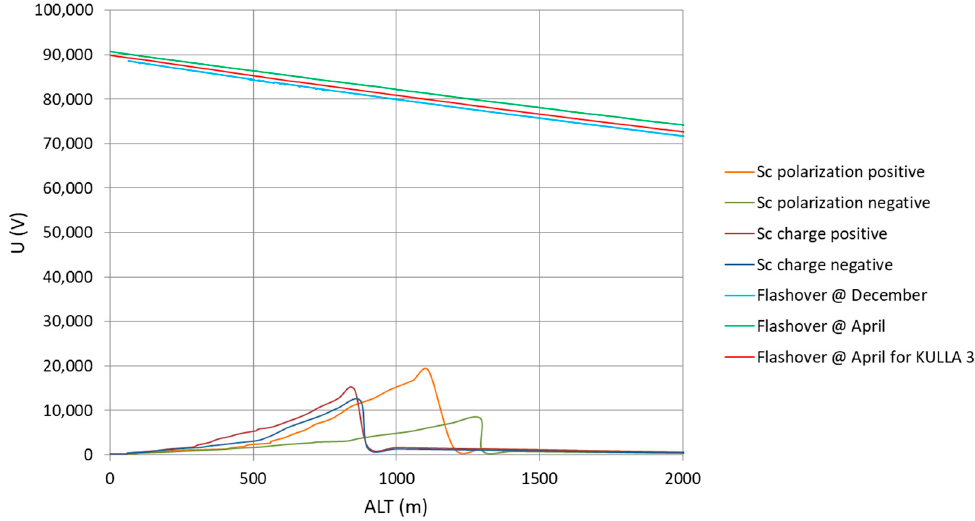
Figure 2. The flashover and induced voltage through the Stratocumulus clouds on the 140 m-long fully airborne antenna during the ascent.